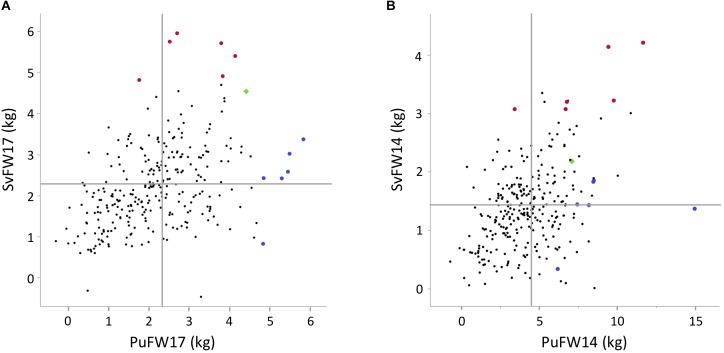
Plots of BLUE accession estimators for different traits between the two field experiments, (A) FW17, (B) FW14. Red enlarged dots represent the best accessions for FW17 in Svalöv, the blue enlarged dots in Pustnäs, and the green square represent an accession that has high FW17 at both experiments. Horizontal lines indicate the BLUE means in Svalöv and vertical line indicate BLUE means in Pustnäs.